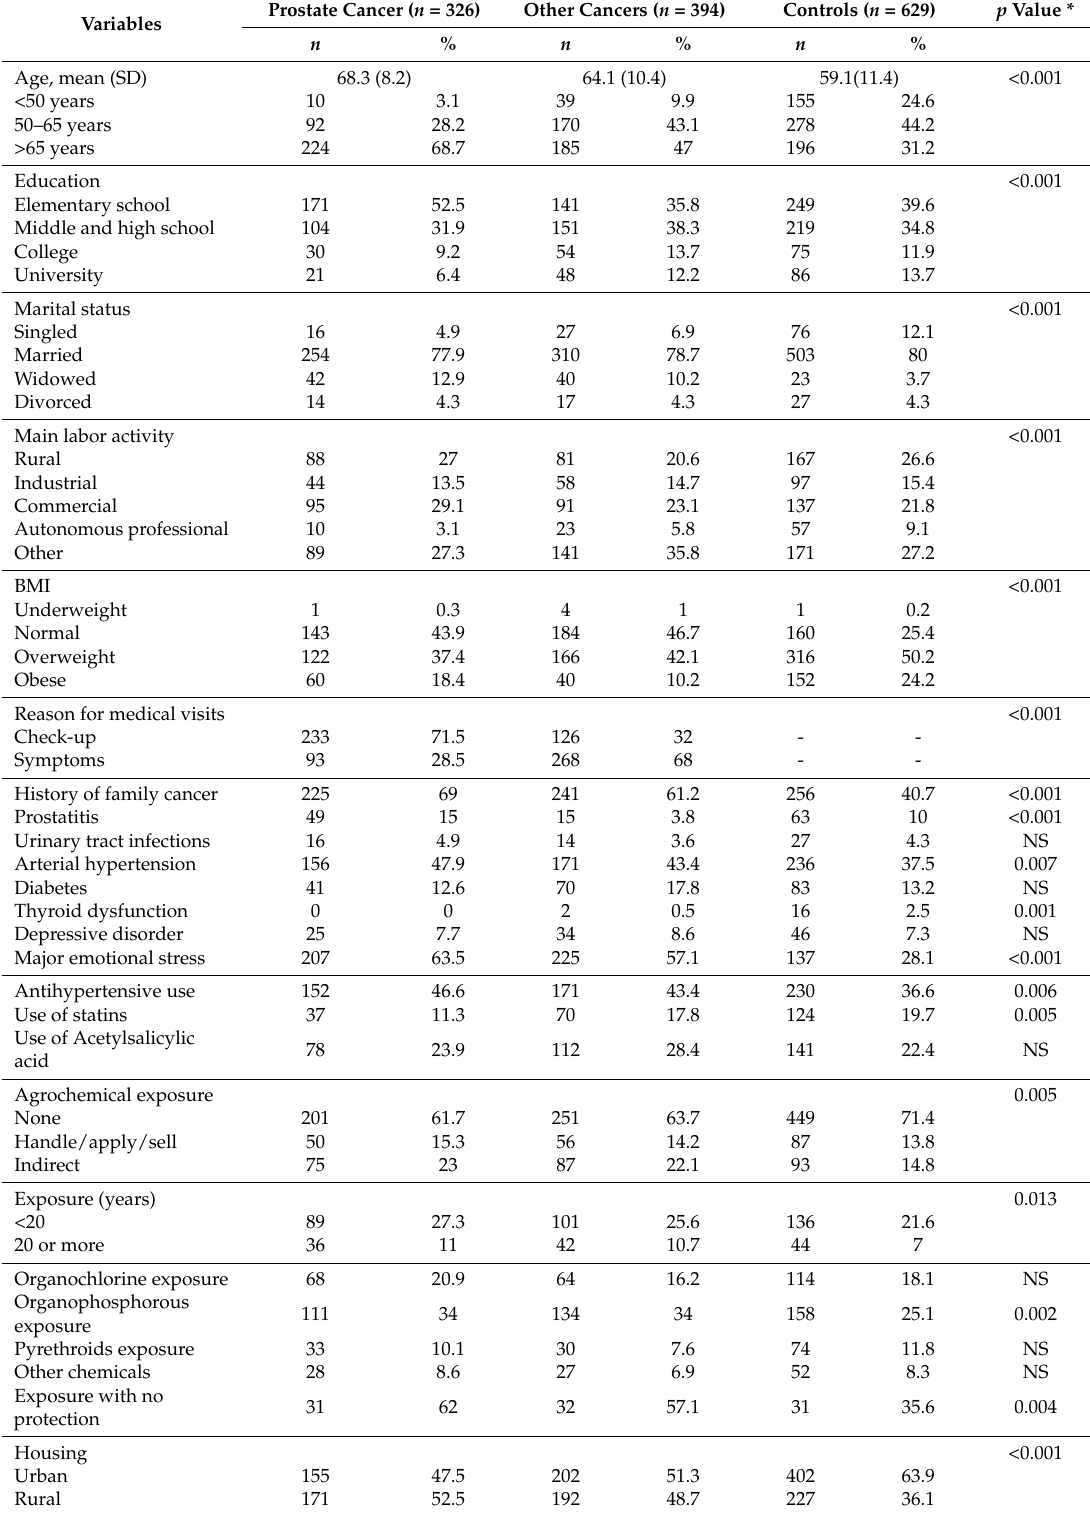
Table 1. Sociodemographic, environmental, and health characteristics of study